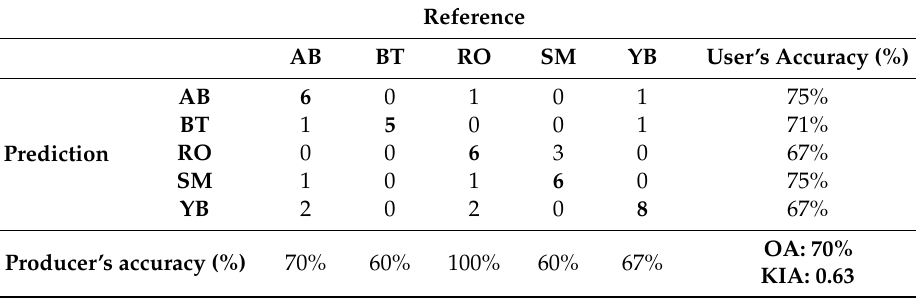
Table11. ConfusionmatrixoftheRFmodelforthehierarchicalapproach: broadleafspeciesclassification. AB: American Beech, BT: Big Tooth Aspen, RO: Red Oak, SM: Sugar Maple, YB: Yellow Birch. OA: Overall accuracy, KIA: Kappa Index of